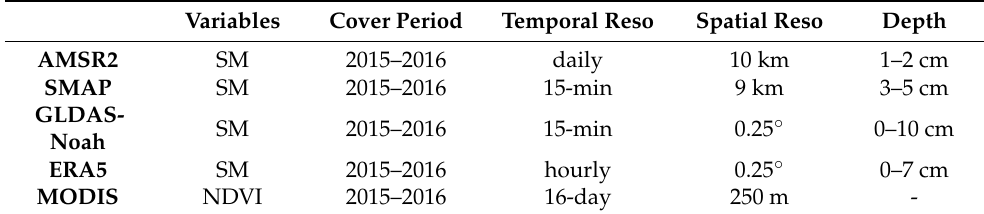
Table 2. Overview of the satellite, GLDAS, and reanalysis datasets used in this study. Variables Cover Period Temporal Reso Spatial Reso Depth